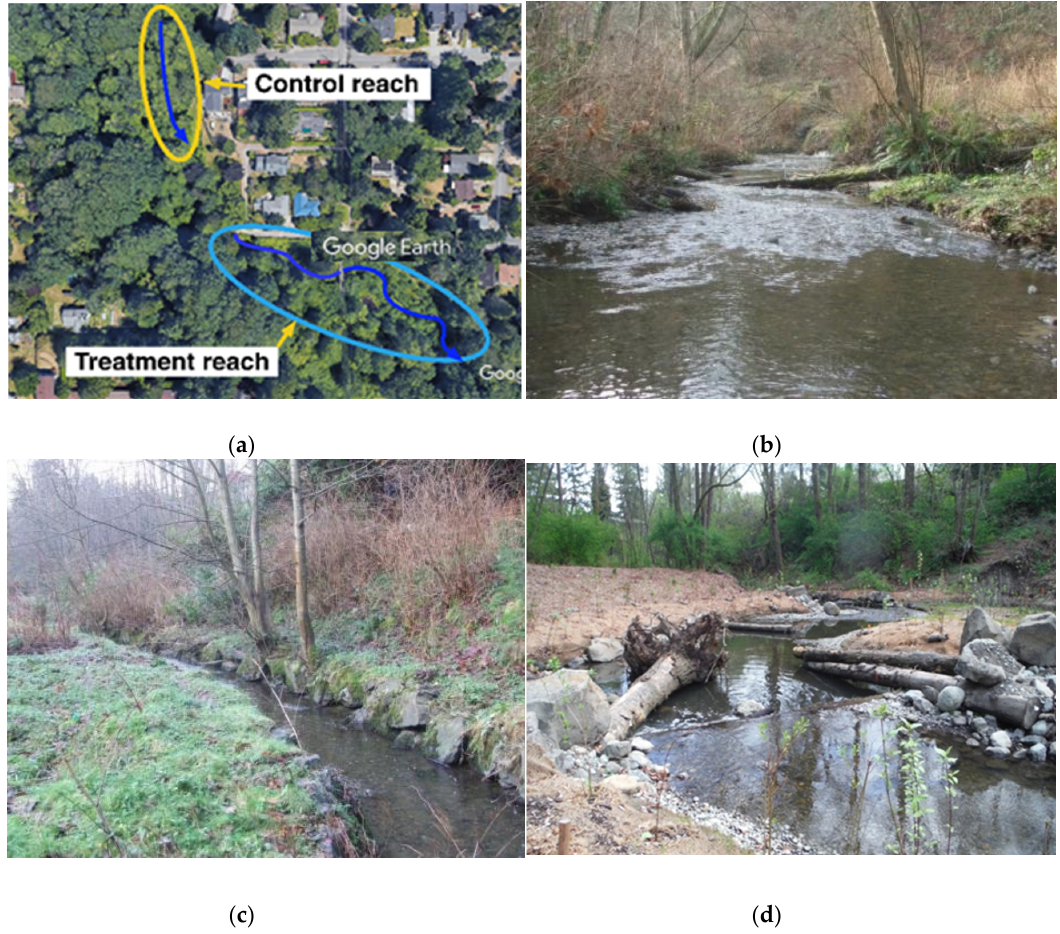
Figure 3. Views of Kingfisher Control and Treatment reach, including: ( a ) Aerial photo showing locations of the Kingfisher Control and Treatment reaches, ( b ) photo of the control reach, and photos of treatment reach ( c ) before, and ( d ) after, construction, taken from close to same vantage point (the “before” is taken closer to the south slope, on the right side of this photo).